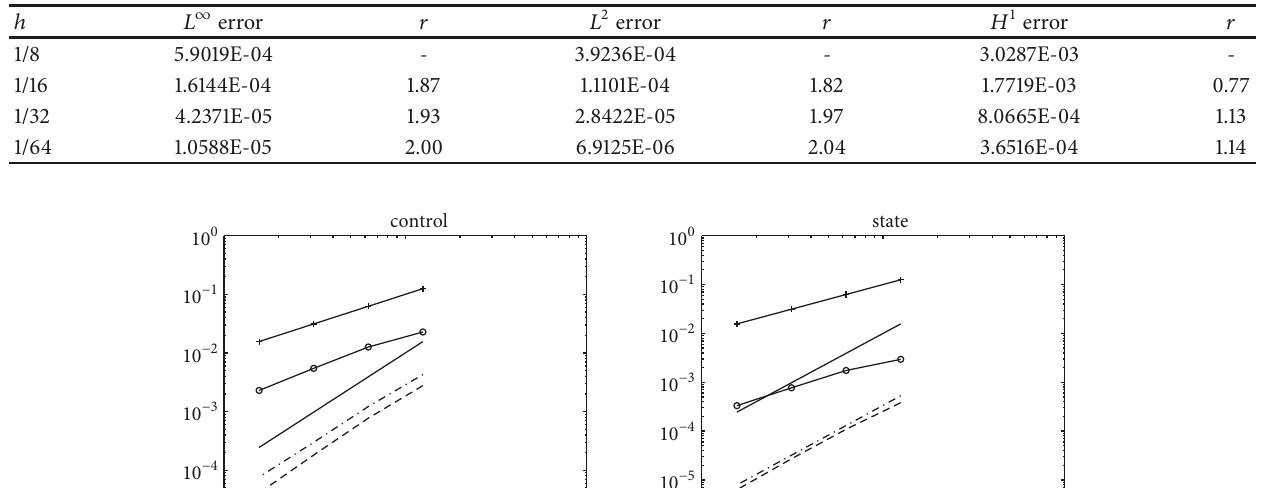
Table 6: Errors of the adjoint state for different error norms.